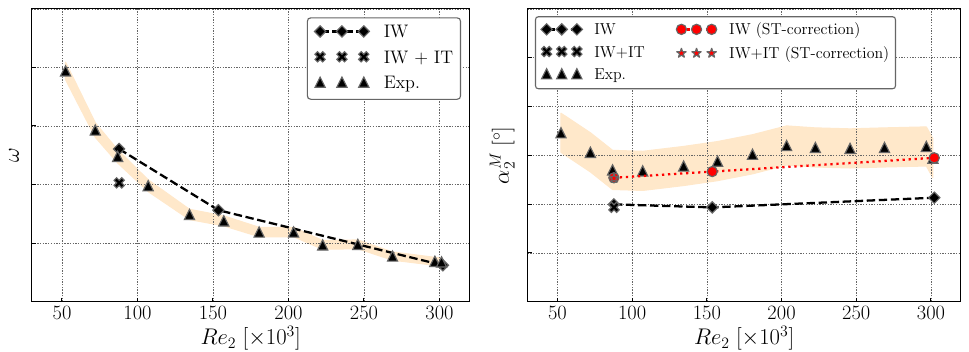
Figure 8. Mixed-out wake traverse measurements: ( left ): total pressure loss coefficient; ( right ): exit angle, with associated streamtube correction shown with red markers. The orange area indicates the uncertainty associated with the measurement chain, of respectively 2.5% and are omitted due to data